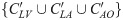
Left: {C
LV ∪ C
LA ∪ C
AO}. Right: {CLV′∪CLA′∪CAO′}. Interpolation was conducted in each short axis group separately. Notice that the region in between groups is not interpolated.